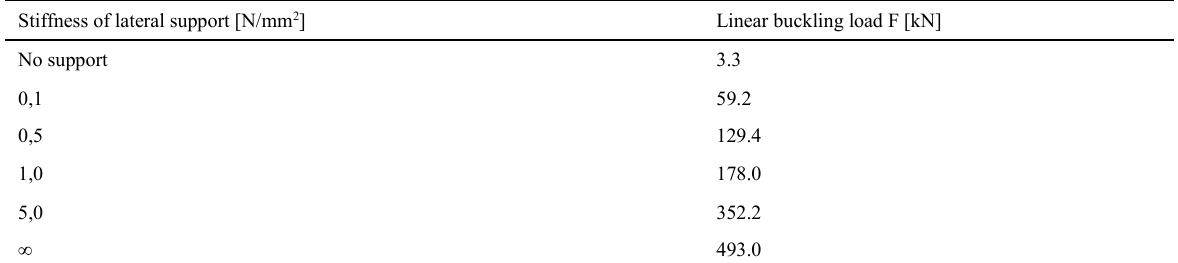
Fig. 7 First mode shapes from linear buckling analysis for different horizontal stiffness values. Table 1: Overview of linear buckling load related to stiffness of lateral